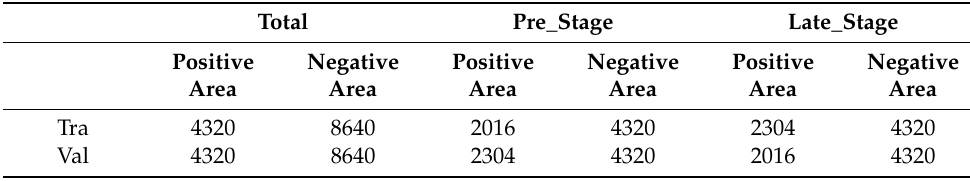
Figure 1. The culture model for assessing the presence of abnormal cells in a product. In this suspension culture system, MRC-5, normal cells as product model, and HeLa-GFP, abnormal cells as cellular impurity model, were co-cultured ( a ). Positive areas (pArea) in which normal cells and cancer cells coexist in co-cultured wells and negative areas (nArea) in which normal cells alone exist in monoculture wells were excised from whole-well bright-field images over time in each well, as inputs for a DL algorithm ( b ). Table 1. Image datasets used in Deep Learning.